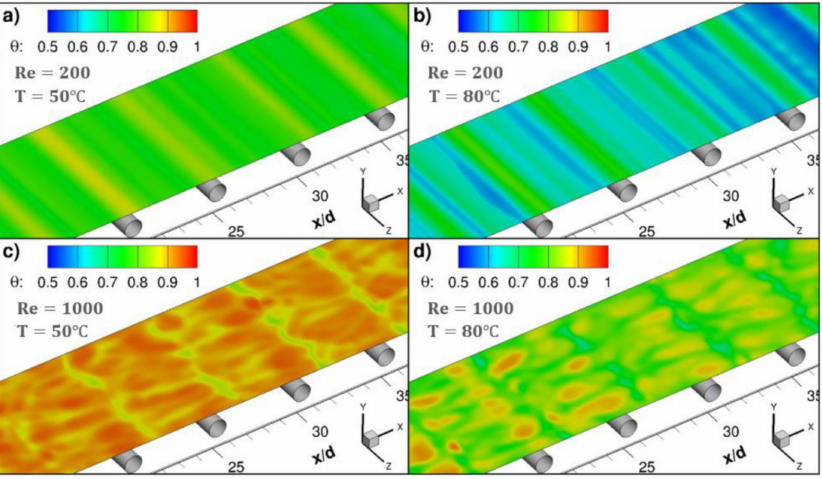
Figure 11. Instantaneous contours of the temperature polarization coefficient, θ , on the top membrane surface at a non-dimensional time τ i with the addition of filaments [17]. Reproduced with permission from Elsevier, 2019. ( a ) Re = 200, T = 50 ◦ C; ( b ) Re = 200, T = 80 ◦ C; ( c ) Re = 1000, T = 50 ◦ C; ( d ) Re = 1000, T = 80 ◦ C.